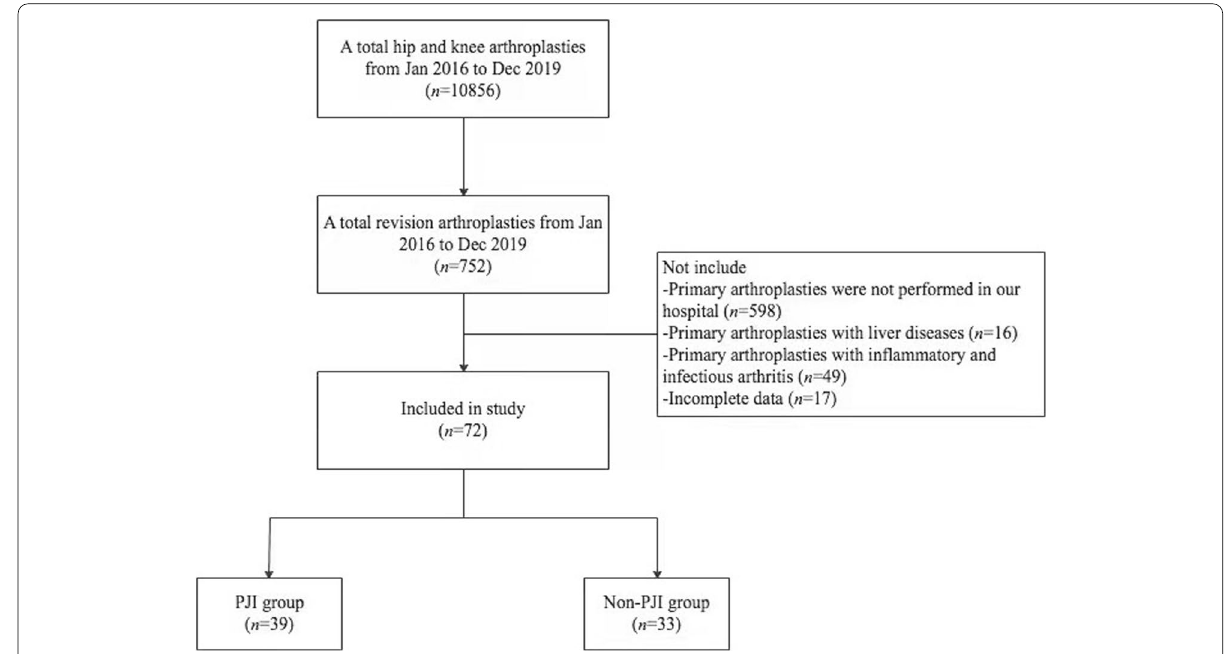
Fig. 1 Patient inclusion and exclusion